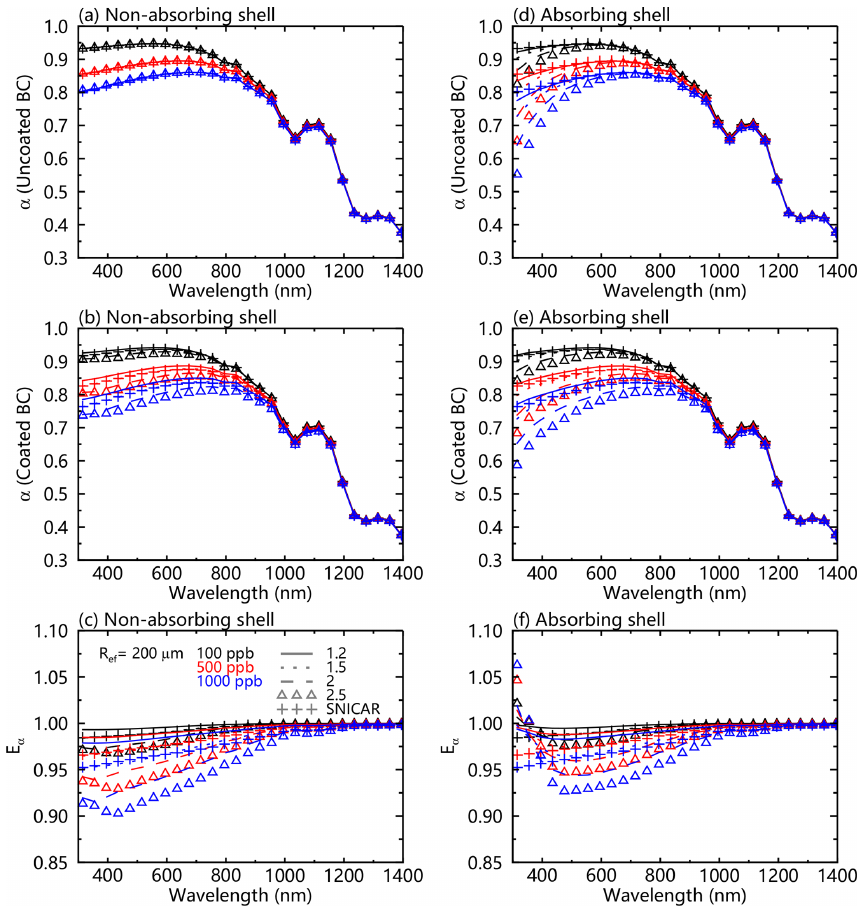
Figure 3. Same as Fig. 2, but for the snow albedo ( α